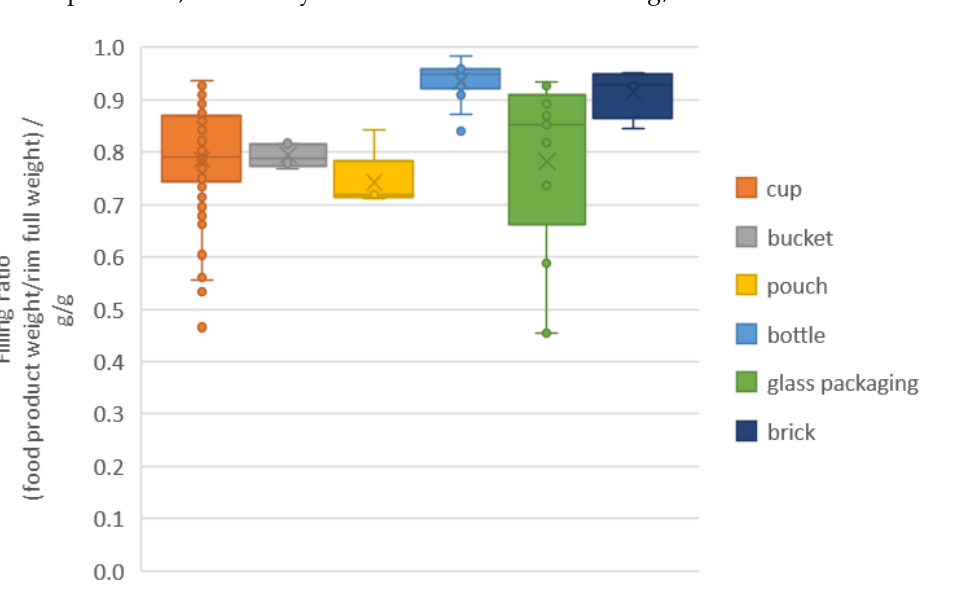
Figure 5. Filling ratios of different packaging categories, simplified density of product 1 g/cm 3 , n = 150 .